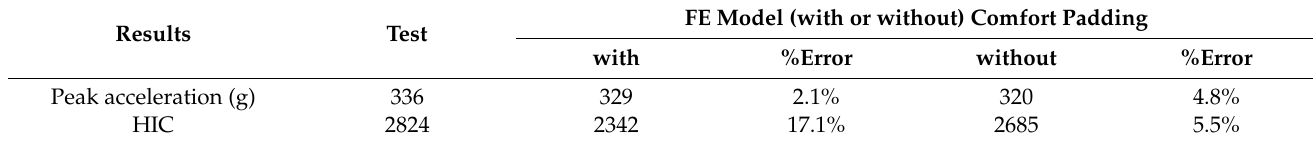
Figure 6. Acceleration during impact test according to TIS 369-2557. Table 3. Comparisons of the results between the test and FE model.